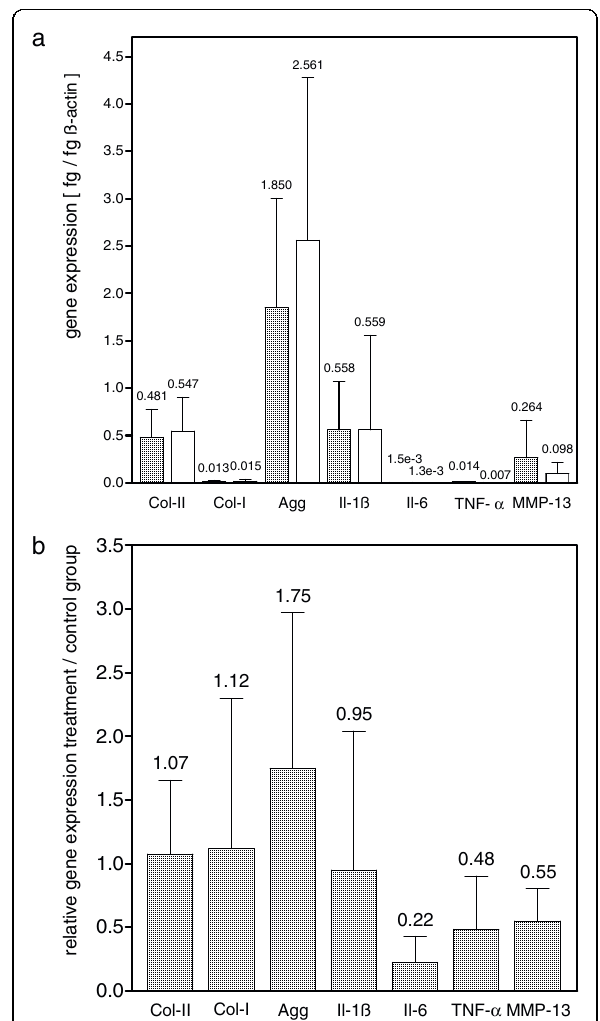
Figure 5 Real-time PCR analysis of osteochondral explants . (a) Gene expression of various genes of matrix synthesis, turnover and inflammation of osteochondral explants left untreated (left column) or stimulated by millicurrent treatment (right column). Specimens were cultivated in-vitro for 3 weeks. The housekeeping-gene b -actin was used as internal standard. P = 0.05. (b) Calculated relative gene expression of treatment samples in relation to control samples of the same patients, where gene expression of control samples was set as